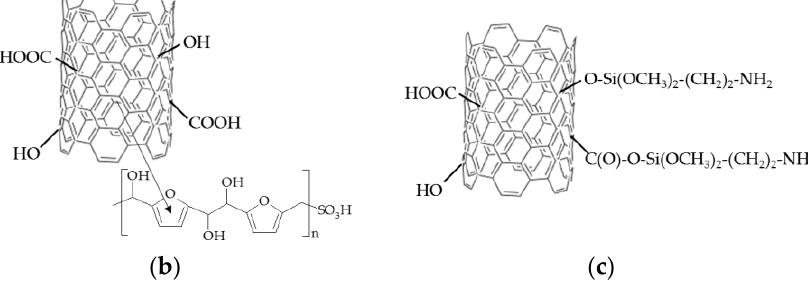
Figure 2. The scheme of the surface fragments of functionalized CNTs: CNTs-COO − ( a ), CNTs-